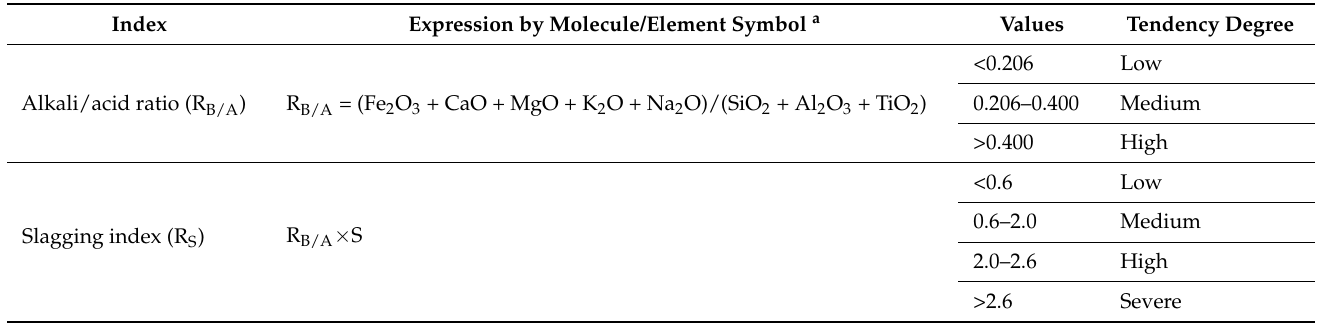
Table 4. Suggested indices for slagging and fouling tendency when using SRFs in industrial